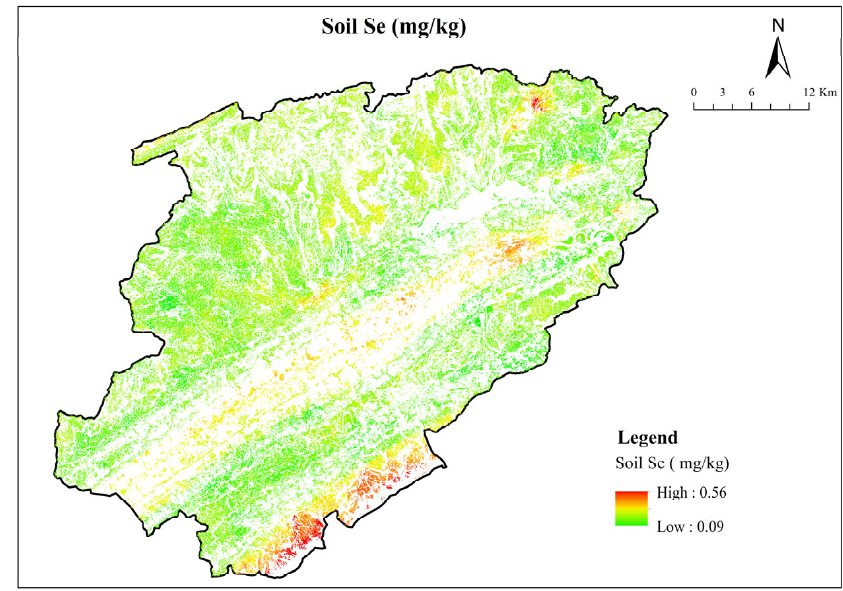
Figure 5. The spatial distribution map of soil Se content in Kaizhou.